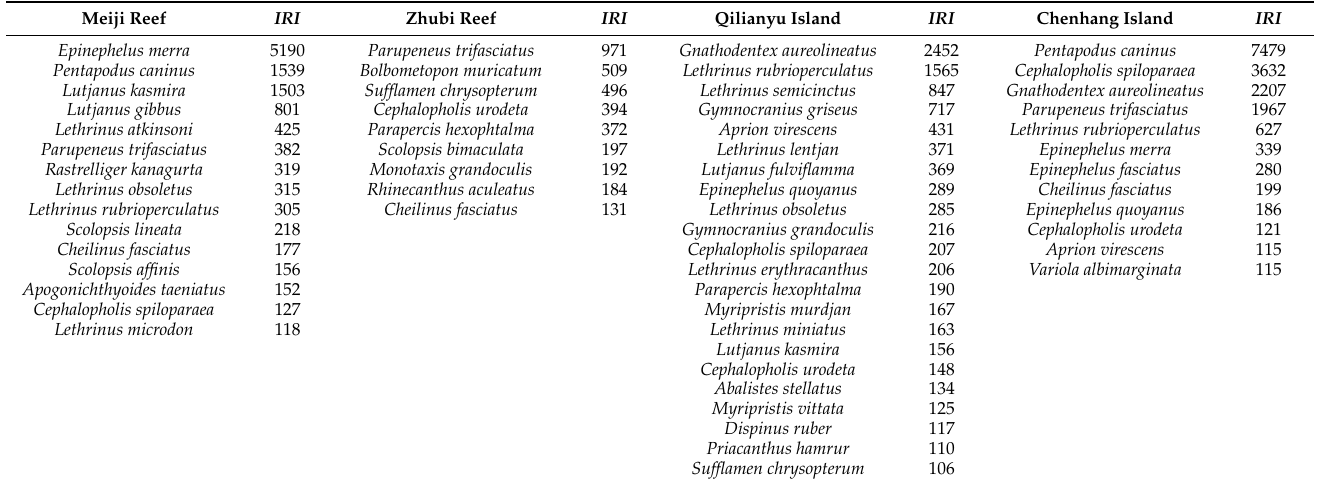
Table 3. Dominant and common species at four coral reefs in the South China Sea regardless of the